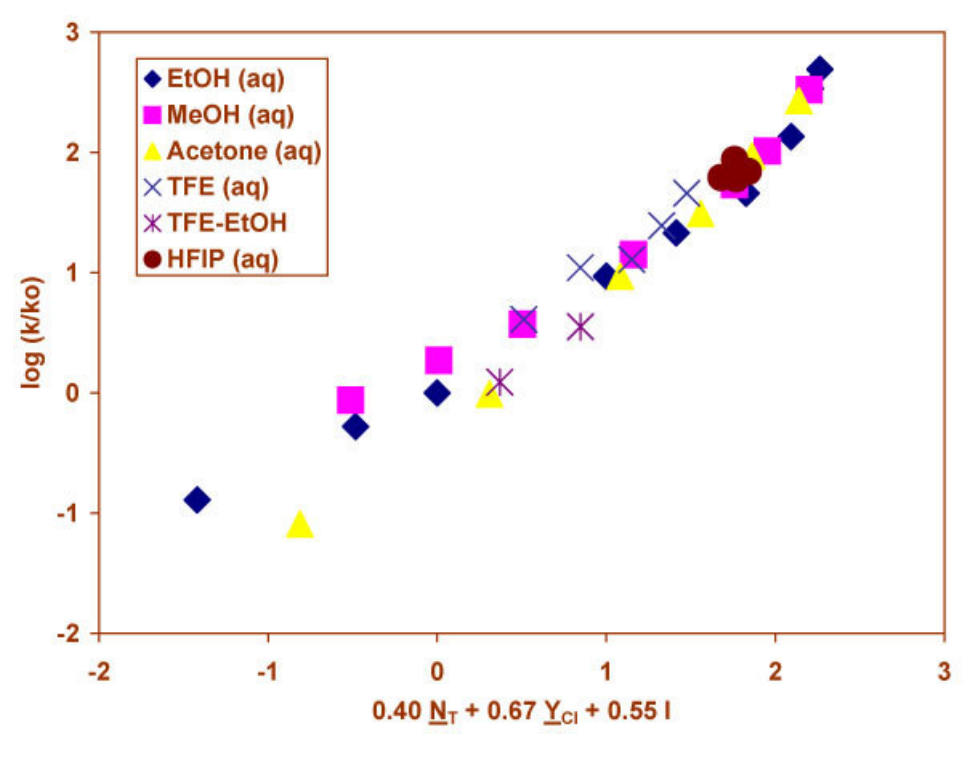
Figure 1. The plot of log (k/k ) vs. (0.40 N + 0.67 Y + 0.55 I) for the solvolyses of N,N- o T Cl diphenylcarbamoyl chloride in pure and binary solvents at 62.5º